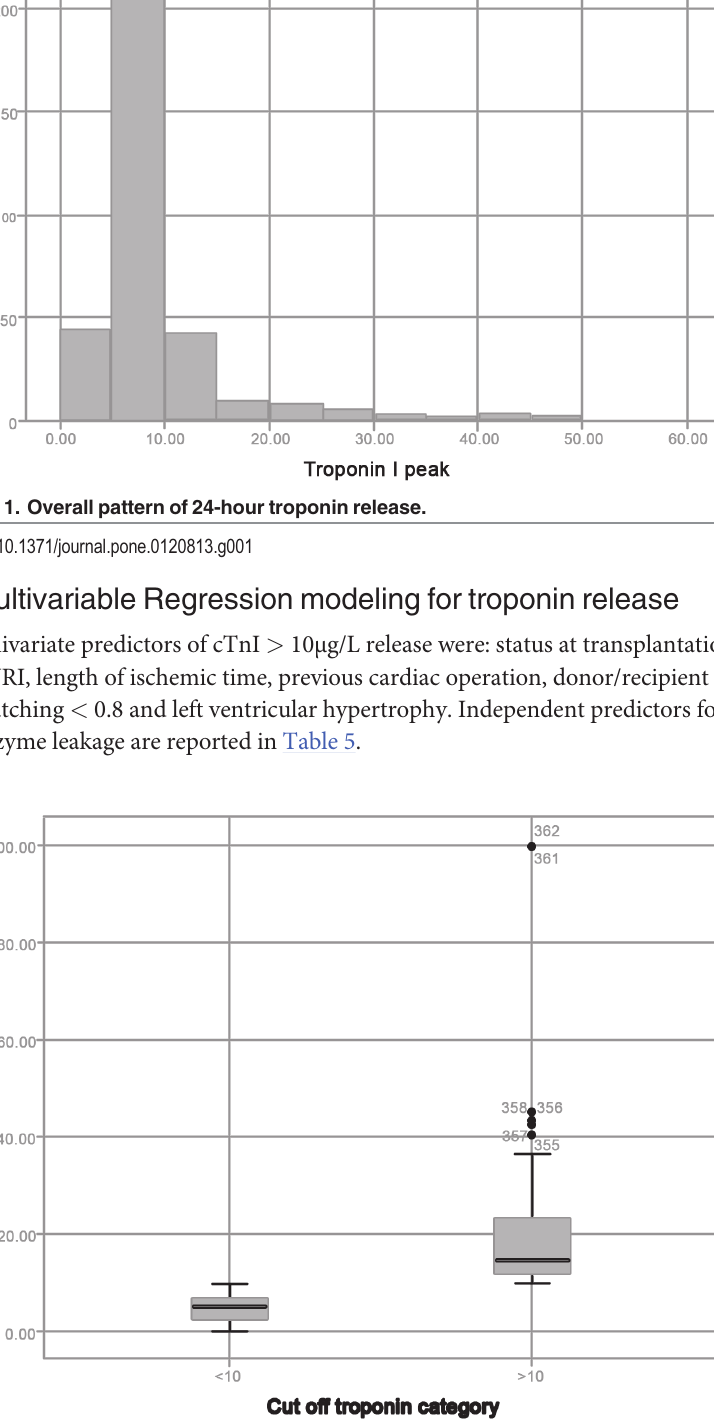
Fig 2. Pattern of distribution of troponin release stratified according to the